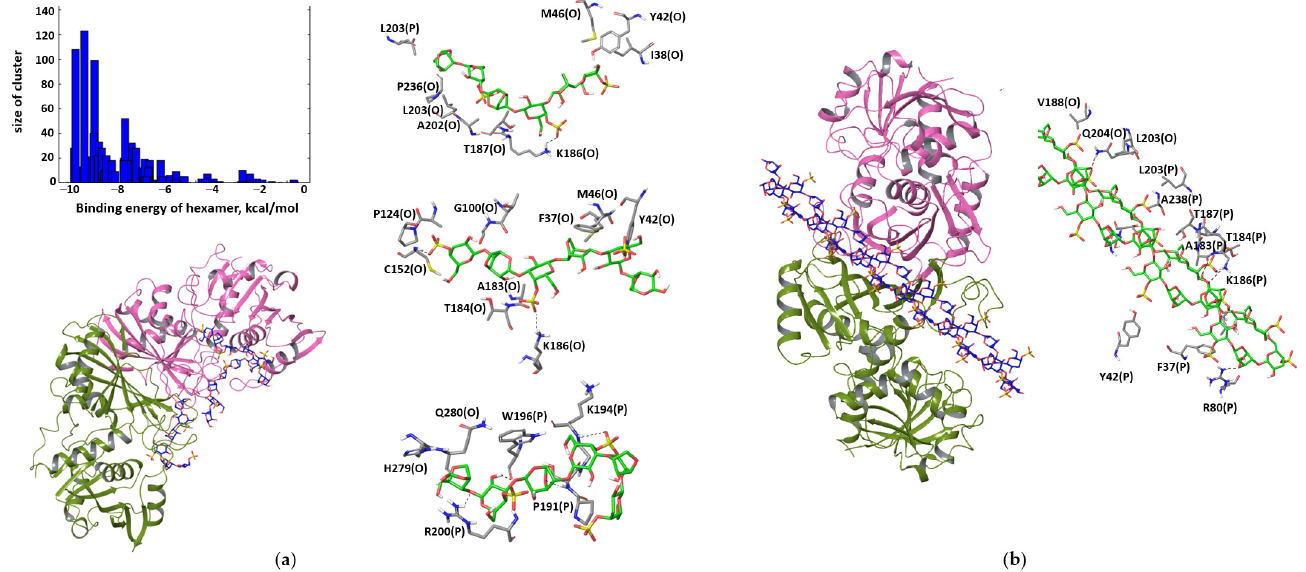
Figure 6. Docking poses of flexible κ‐ carrageenan chain in OP ‐ dimer that may prevent tetramer formation ( a ). The most favorable binding pose of κ‐ carrageenan double helix in the OP dimer ( b ).